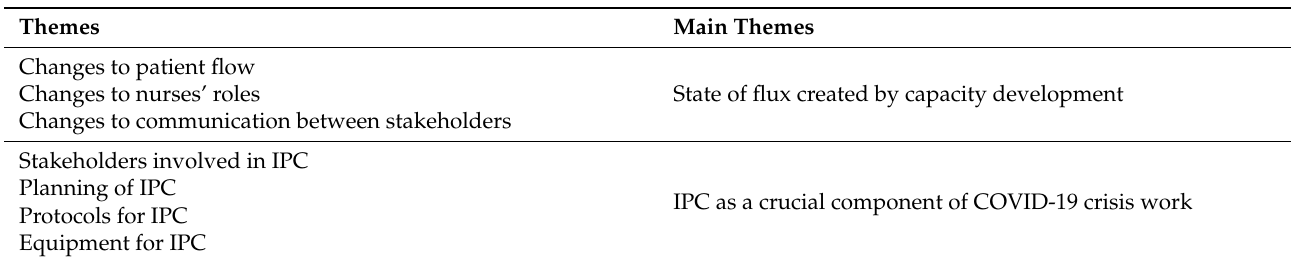
Table 1. Themes and main